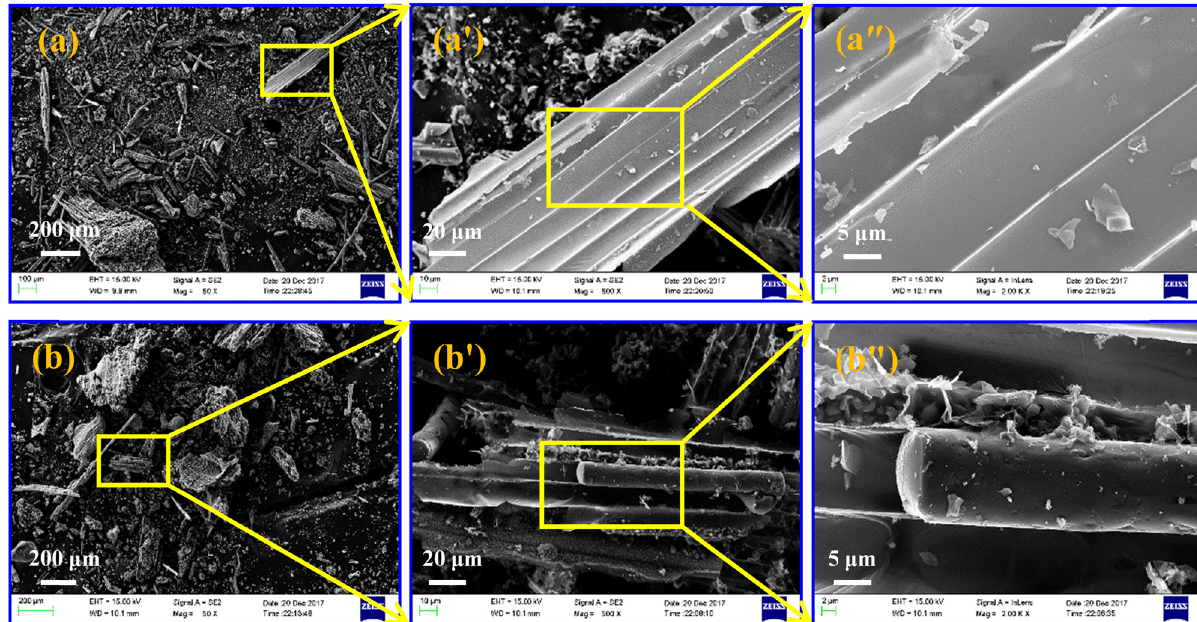
Figure 2: SEM images of sample under di ff erent the ablative conditions: ( a ) 452 W · cm − 2 for 5 s and ( b ) 226 W · cm − 2 for 10 s.